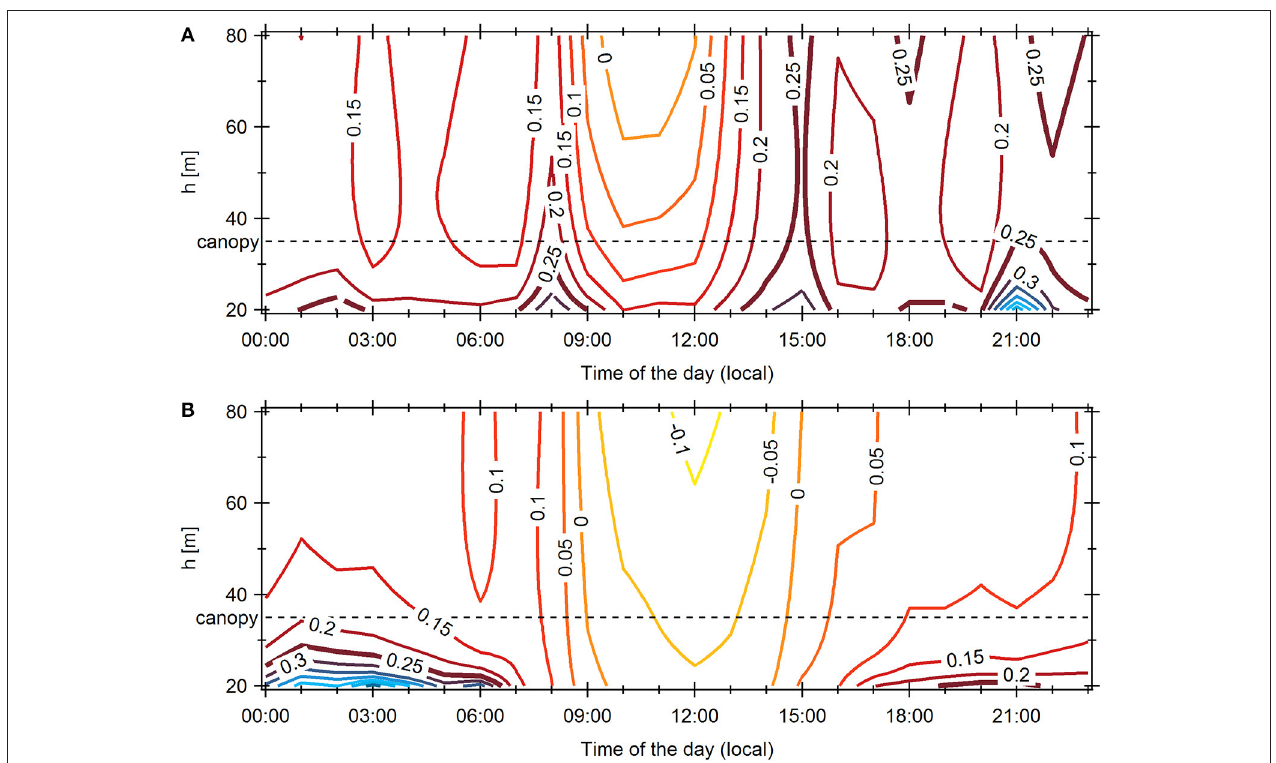
FIGURE 7 | Diel patterns of gradient Richardson numbers from 20 to 80m height above ground level for (A) November 2012 and (B) November 2015. The critical Richardson number (0.25) is indicated with a thicker line. The dashed line represents canopy top